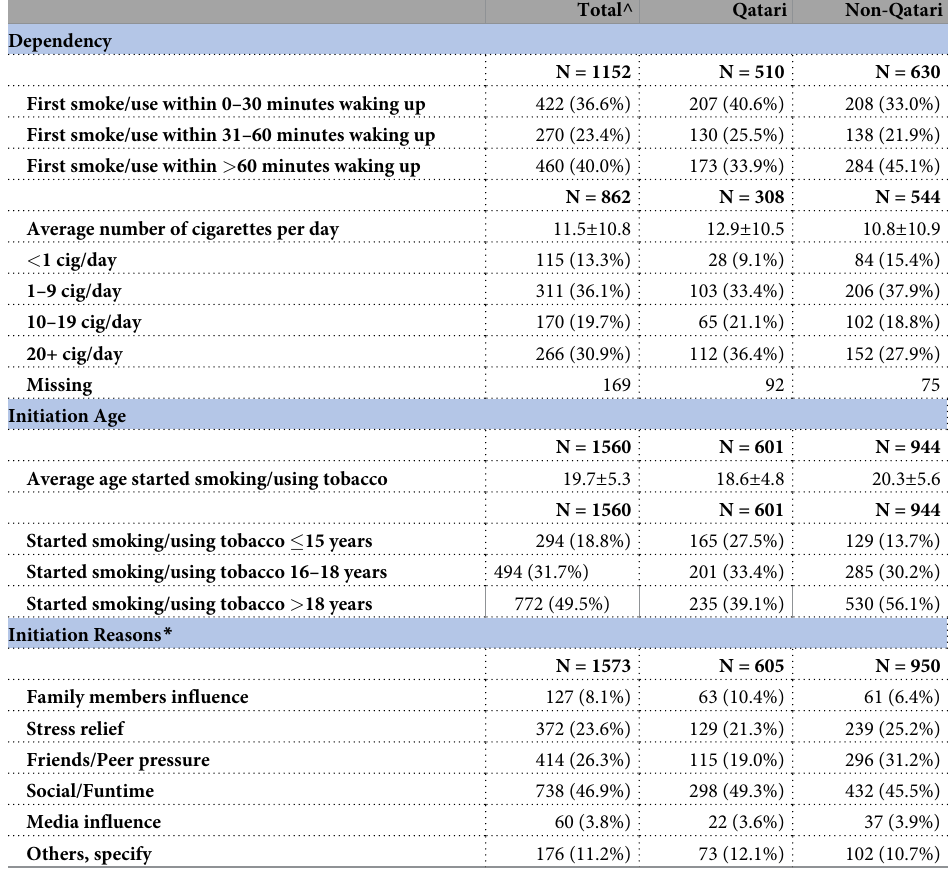
Table 4. Dependency, age and reasons of initiation of current tobacco users by nationality (n,